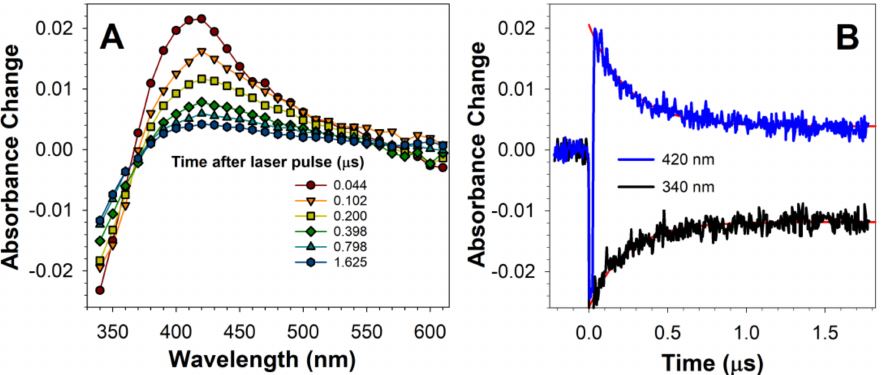
Figure 4. The transient species formed after photoexcitation of DHE is quenched by oxygen. Representative absorption spectra of transient species generated at indicated times after photoexcitation of oxidised DHE ( A ), and kinetics of transient formation and decay recorded at 420 nm, and sample bleaching and recovery monitored at 340 nm ( B ). Oxidised DHE was solubilised in air-saturated acetone and exposed a 5 ns laser pulse of 355 nm wavelength. The transient species exhibits an absorption maximum at about 420 nm and decays concomitantly with partial recovery of absorption at 340 nm but on a much faster time scale than in the de-oxygenated solution, as shown in Figure